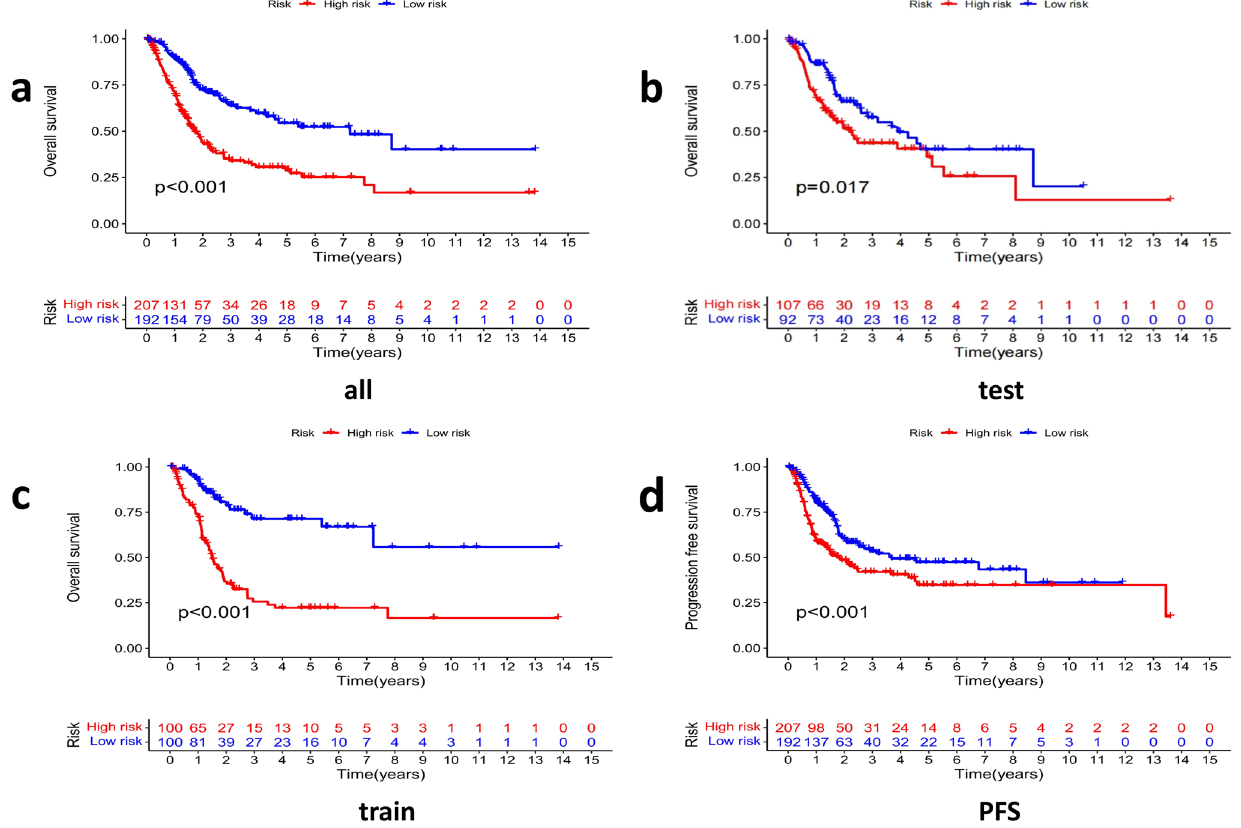
Fig. 4 The prognostic value of lncRNA signature a – d Kaplan–Meier survival analysis compared low risk and high risk groups in all ( a ), test ( b ), train ( c ) groups, and PFS ( d ) in all